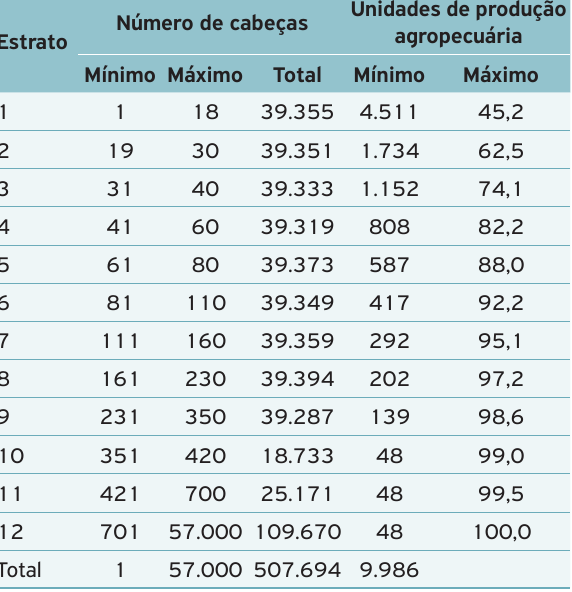
Tabela 2. Número de unidades de produção agropecuária com ovinocultura, por faixa de número de cabeças, estado de São Paulo,